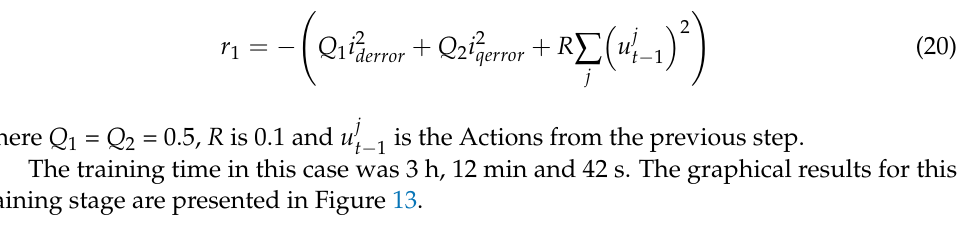
Figure 12. The MATLAB Simulink subsystem of the RL-TD3 agent for the correction of the u dref and u qref commands.